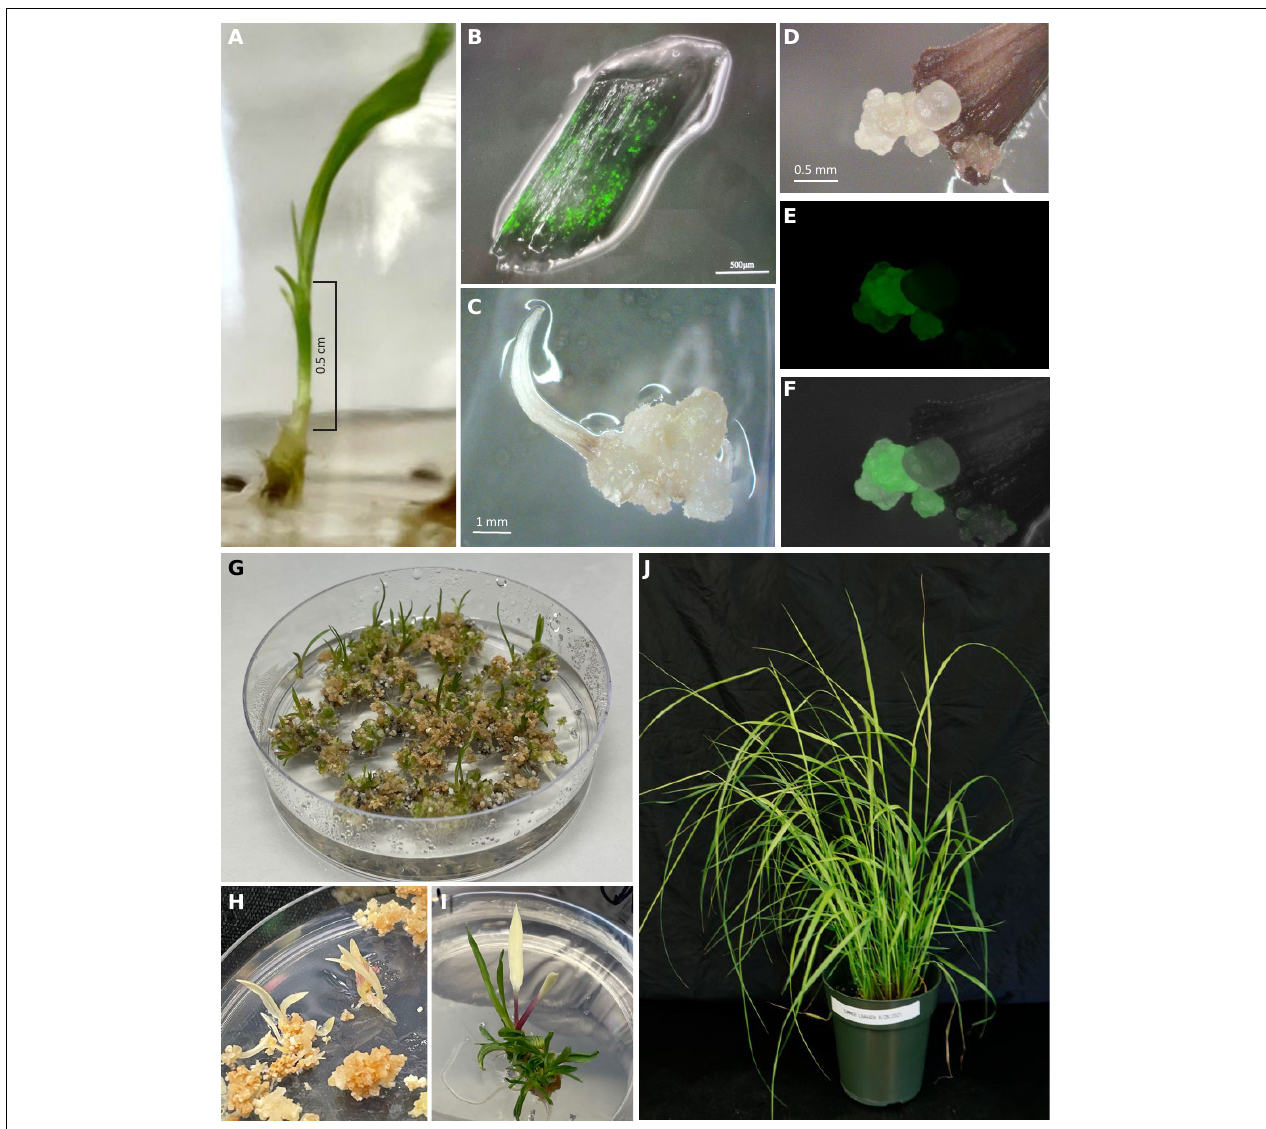
FIGURE 2 | Regeneration of transgenic plants of the upland switchgrass cultivar Summer. (A) 7-day old seedlings from which basal stems (within the bracket) containing whorls of leaves including leaf sheaths and blades were excised for Agrobacterium infection. (B) Transient expression of GFP on immature leaf segments 7 days post-inoculation. (C) Non-embryogenic callus formed on explants treated with RM medium only (no-infection control). (D) Embryogenic callus formed on explants infected with Agrobacterium . (E) GFP expression on the same callus as shown in panel D . (F) Overlay of images (D,E) . (G) Regeneration of healthy shoots 3 weeks following the heat-shock treatment. (H) An embryogenic callus producing entirely albino shoots. (I) An embryogenic callus producing a mixture of green shoots and an albino shoot. (J) Soil-grown transgenic plants 2 months after being established in the